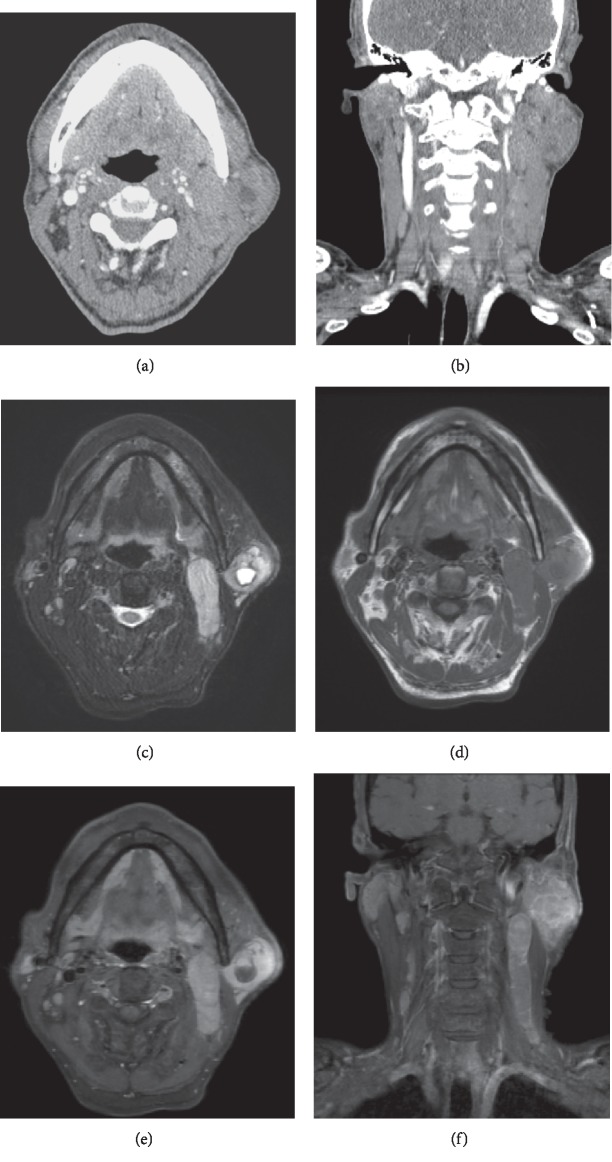
(a, b) A CT scan demonstrated a nodular, isodense, and necrotic mass in the left parotid gland and multiple homogenous density, necrotic, and enlarged lymph nodes in the left lateral neck. (a) Postcontrast axial CT image and (b) coronal image. (c–f) MRI of the parotid gland and neck revealed a lobulated necrotic mass that involved the superficial and deep lobes of the left parotid gland and multiple homogenous densities with necrotic enlarged lymph nodes in the left lateral neck. Indeterminate enlarged lymph nodes were observed on the right lateral neck. (c) T2-weighted axial image, (d) T1-weighted axial image, (e) postcontrast T1-weighted axial image, and (f) postcontrast T1-weighted coronal image.